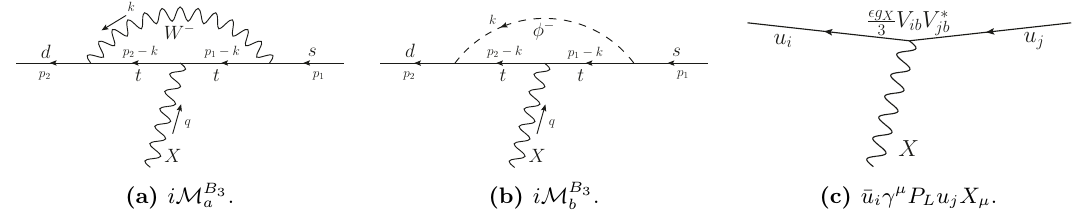
Figure 4. The diagrams which contribute to the loop-induced dsX FCNC process with X gauge boson coupled to B 3 (model II). The loop-induced down-type FCNC (Left and Middle panels) and tree-level up-type FCNC (Right panel) are